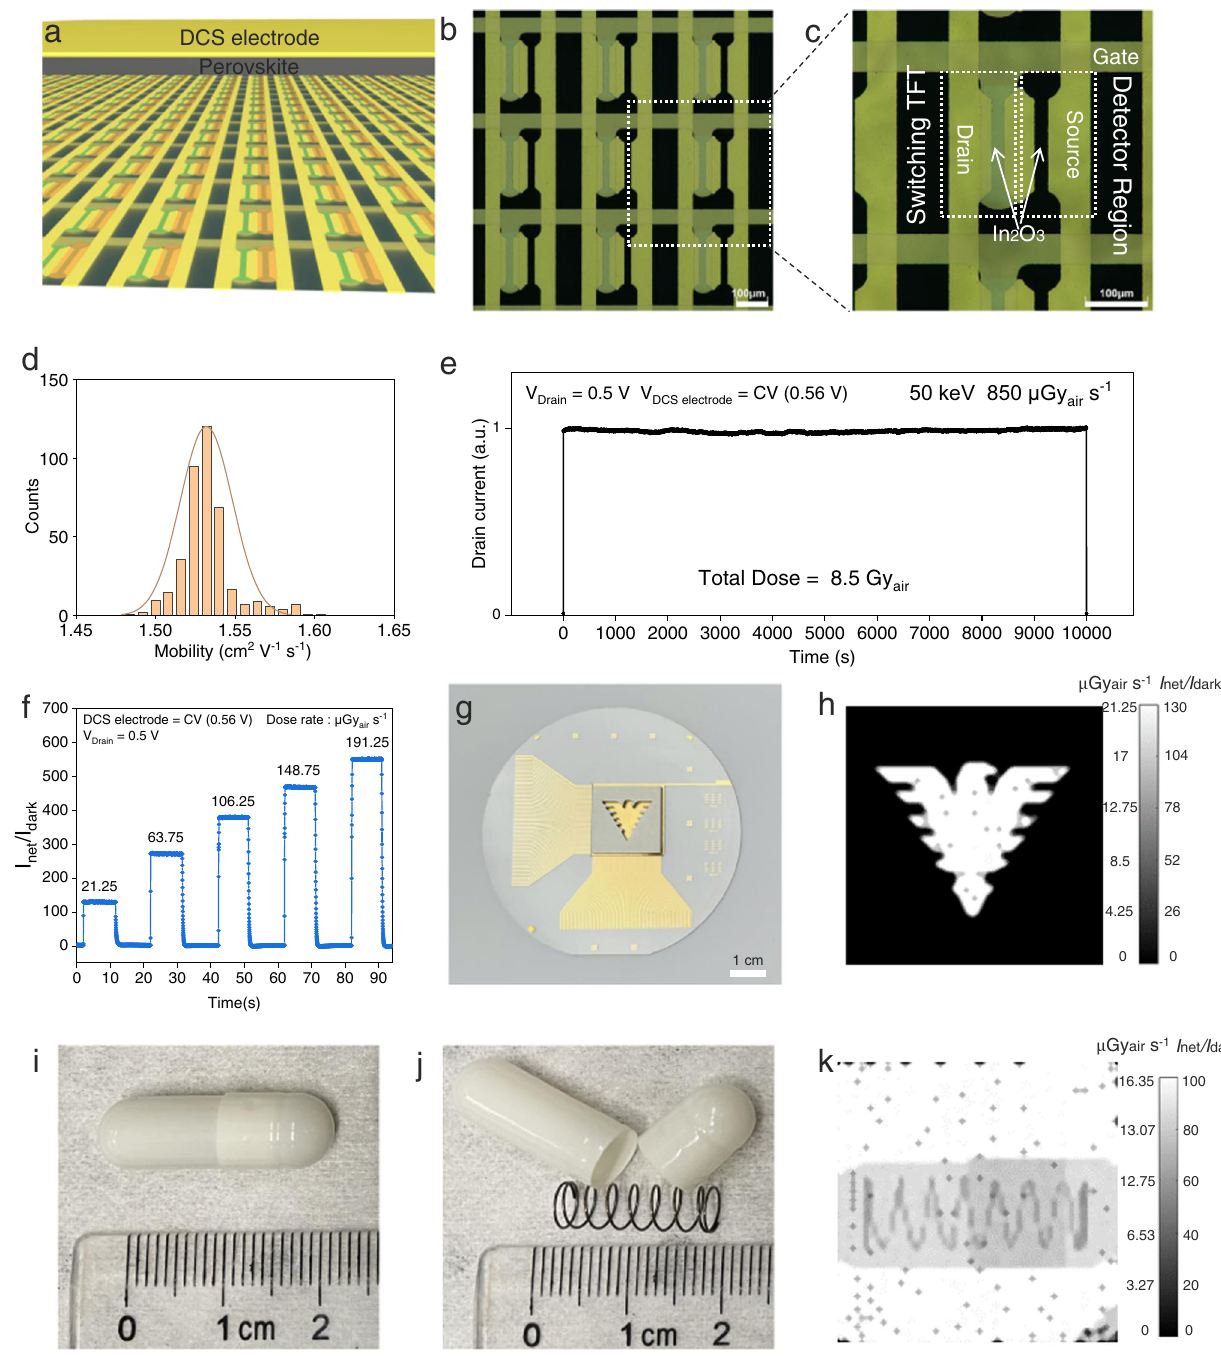
Fig. 5 | DCS X-ray detector array and X-ray imaging. a Schematic illustration of theDCSX-raydetectorarray. b Opticalimageofafractionofdetectorarrayofnine pixels. c , The pixel pitch is 312.5 μ m. The photosensitive area is 30 μ m×200 μ m. d Electron mobility distribution of randomly selected400 pixels. e Stability test of the DCS detector. The X-ray photon energy is 50keV and the dose rate is 0.85 mGy air s − 1 . The total received dose is 8.5 Gy air . f The image contrast is determined